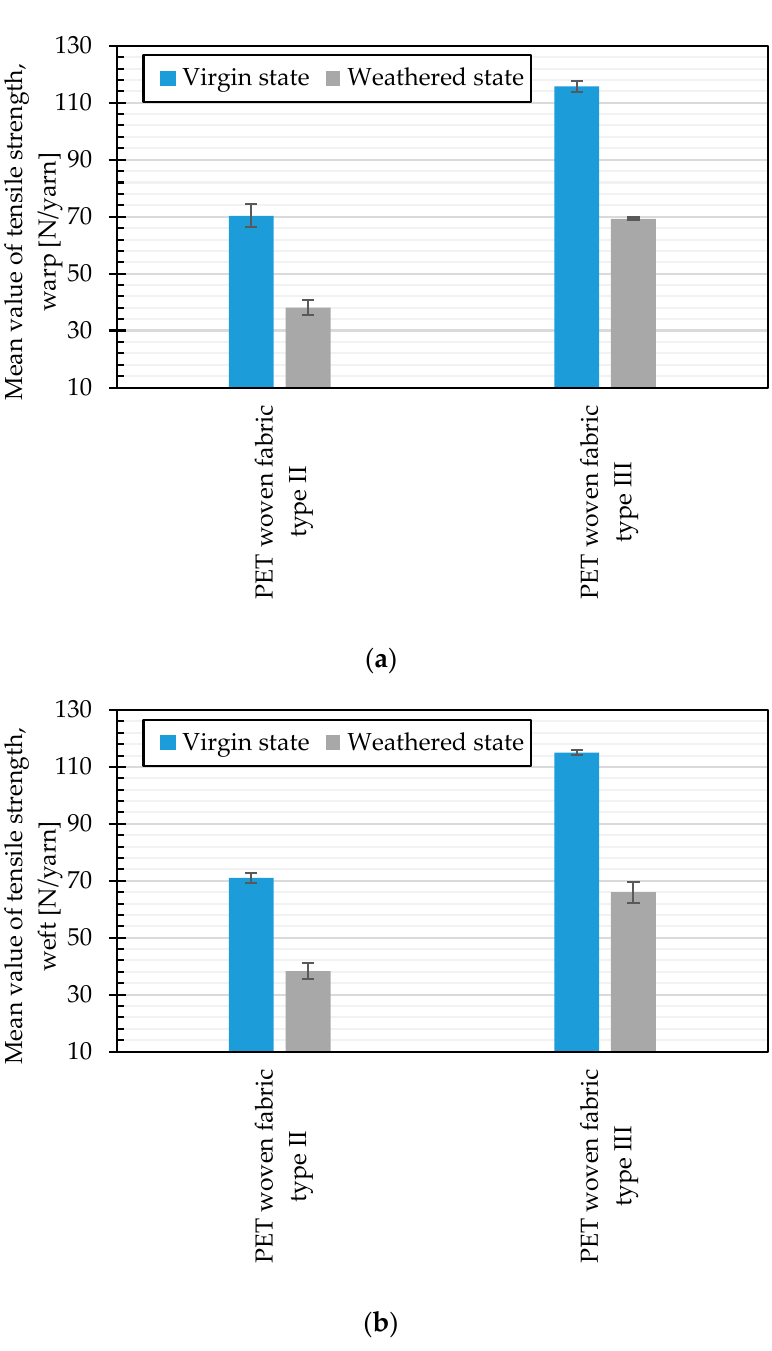
Figure 21. Comparison of the mean tensile strength, virgin, and weathered states (artificial weathering, Method M4, 120 h): ( a ) warp direction; and ( b ) weft direction.